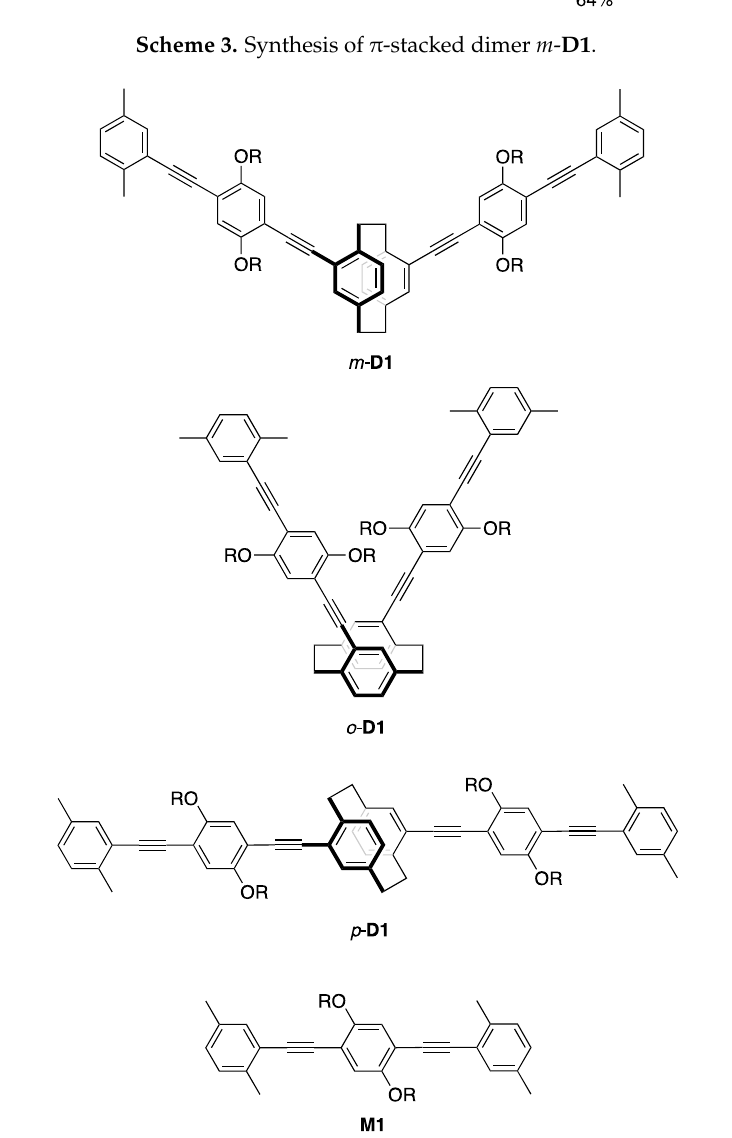
Figure 2. Structures of π -stacked dimers, m -, o -, p - D1 and monomeric model compound M1 (R = C 12 H 25 ).